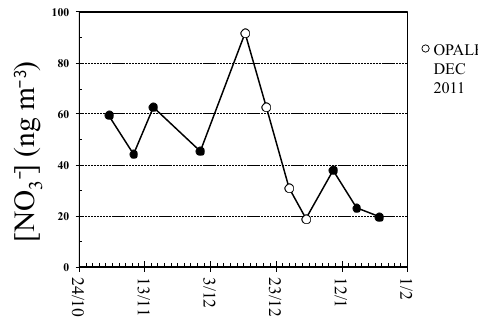
Figure 2. (cid:49) 17 O (primary y axis) and δ 15 N (secondary y axis) of atmospheric nitrate collected between November 2011 and Jan- uary 2012. The samples collected during the intensive measurement period (December 2011–January 2012) are indicated with open symbols.